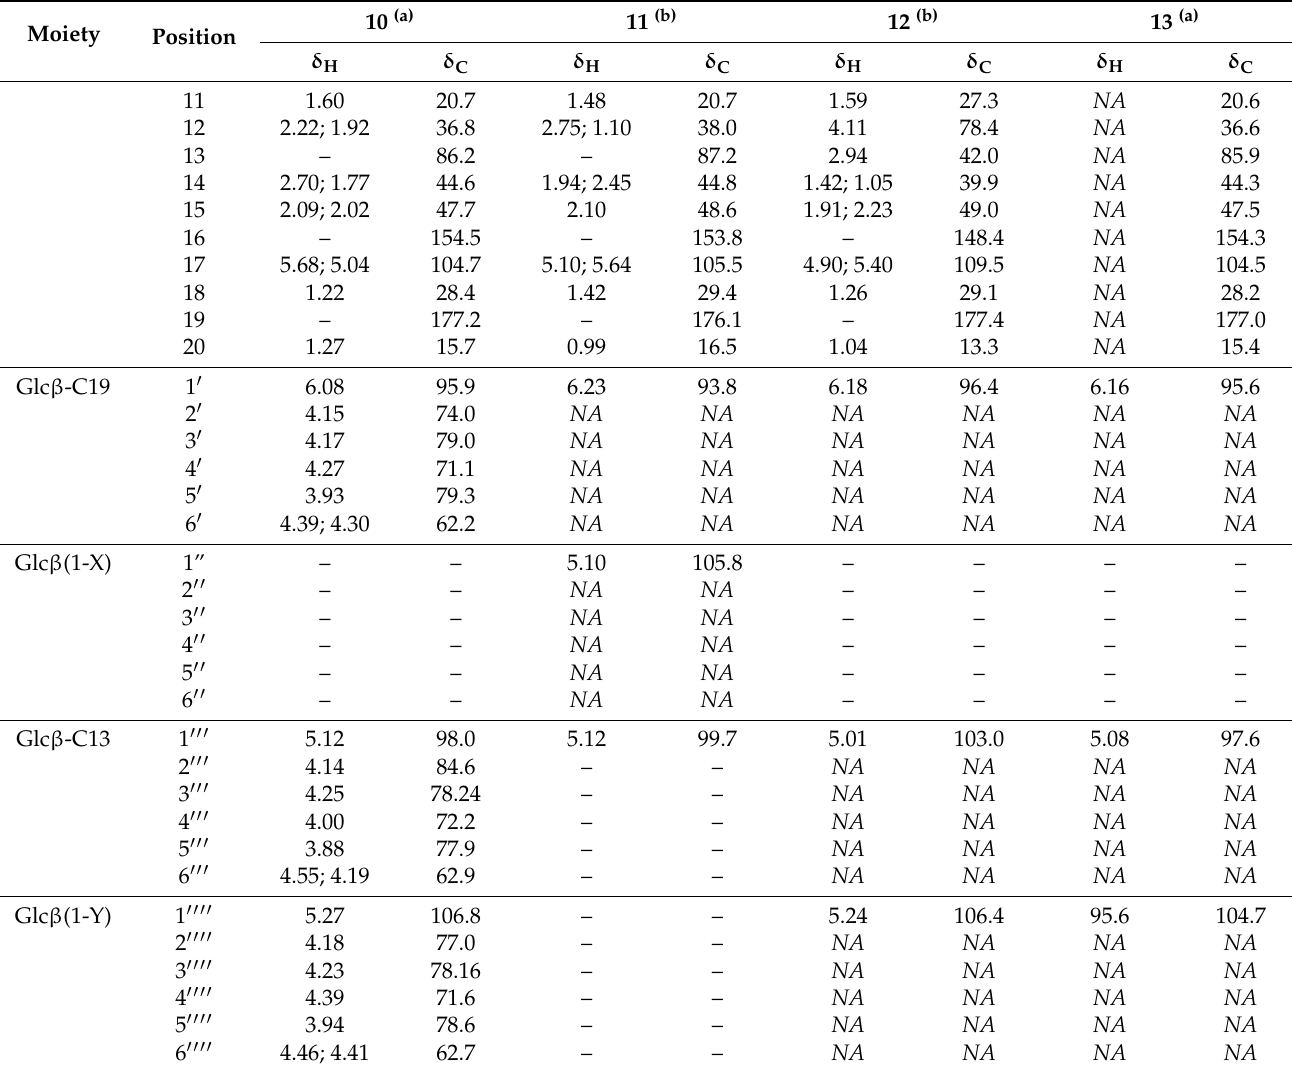
In Table 7 are presented DGs with four sugar units, one xylose and three glucoses with different arrangements whereas in Table 8, a few examples of DGs with four sugar units, one rhamnose or 6-deoxyglucose together with three glucose with different